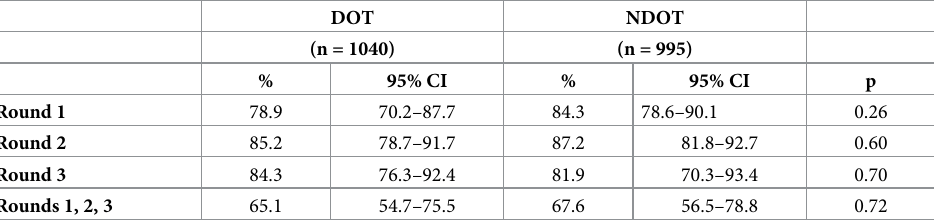
Table 4. Coverage of SMC defined as the proportion of children who received all three days SMC treatments according to the method of observation of the treatment, directly observed treatment versus not directly observed treatment.